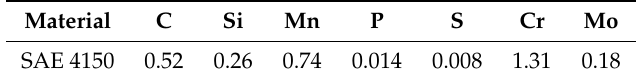
Table 1. Chemical composition of the SAE 4150 in wt.%.